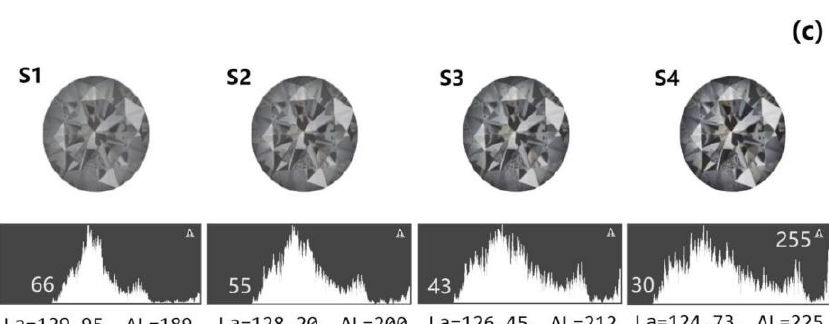
Figure 12. Standard round drill cutting through the PS adjustment to simulate the change of the scintillation intensity. ( a – c ) from S1 to S4, gem scintillation increases with increasing contrast. From longitudinal comparison of S1 of ( a – c ) graphs, gem scintillation decreases with the decrease of lightness. L a = average lightness, Δ L = L max − L min .